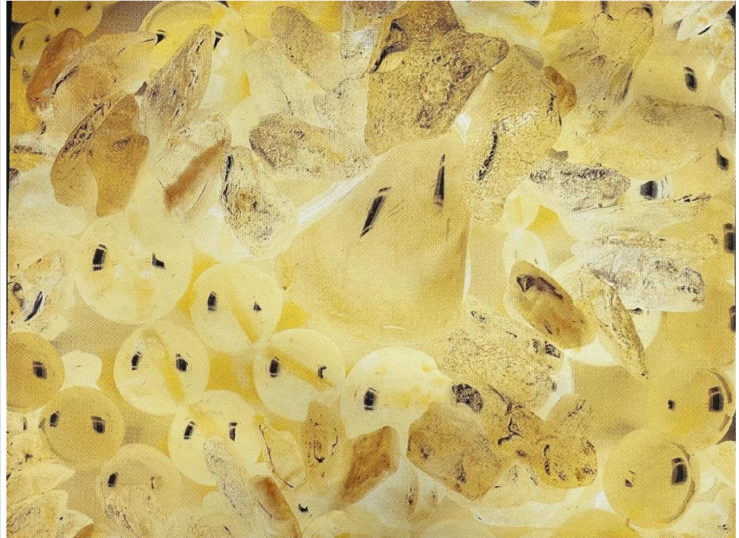
Figure A15. 25LPI, screen-print, 55H mesh, Y = Pyrisma™ Ambercup Orange, M = Iriodin™ Solar Gold, B = Iriodin™ Platinum Gold, C = Iriodin™ Icy White, printed dark to light, black Plike, film positive, print size: 600 mm × 450